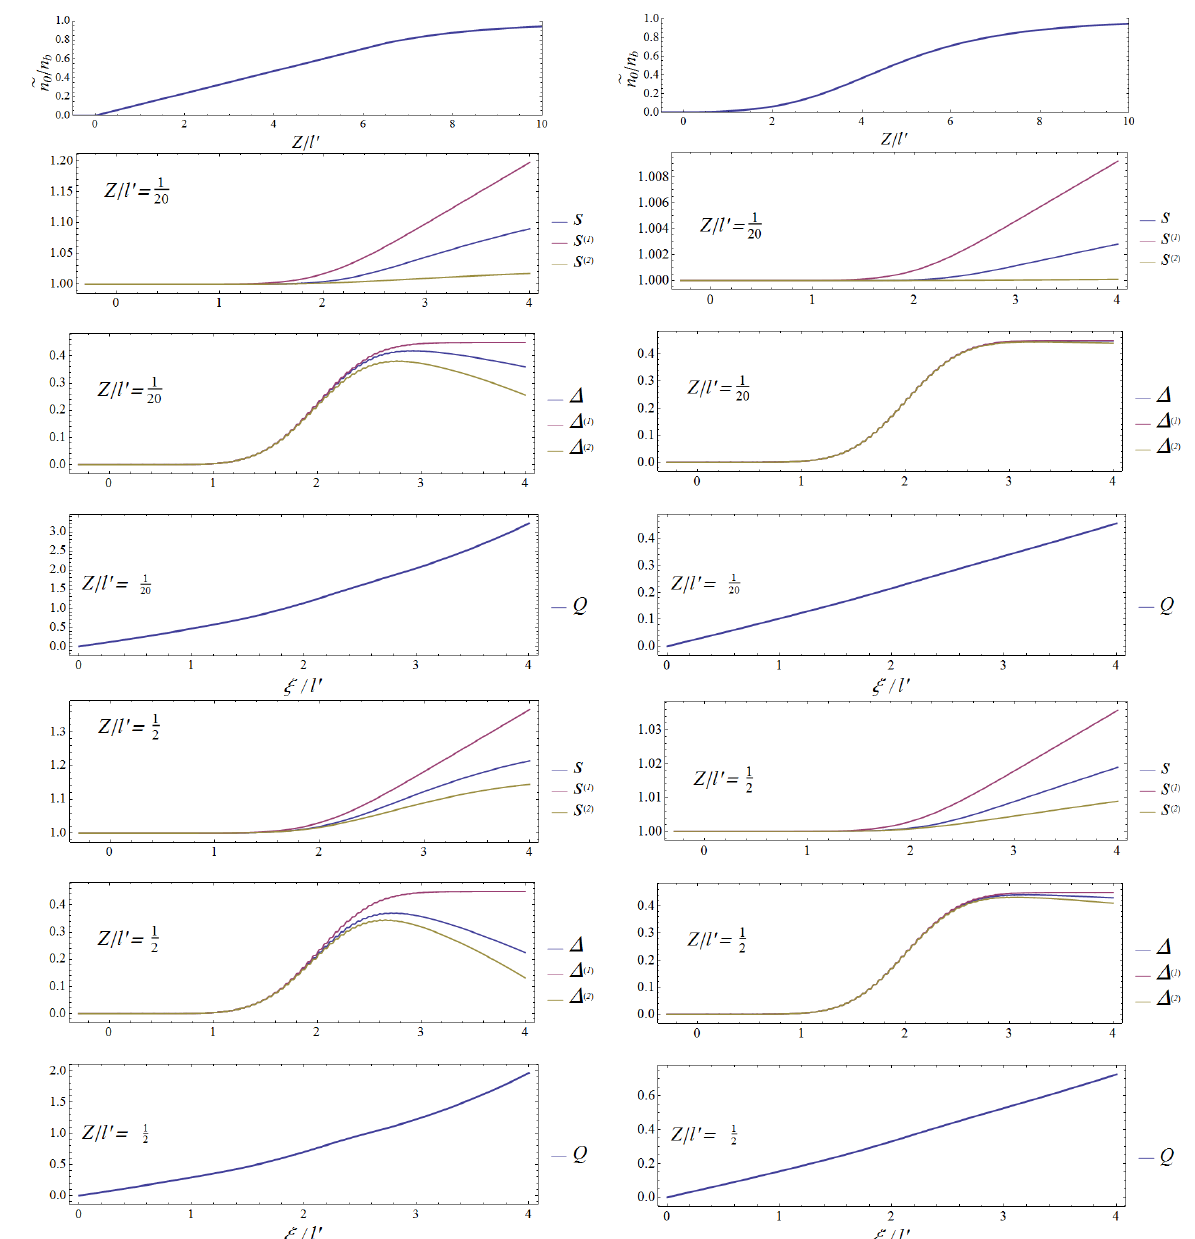
Figure 4. The initial electron densities (3), (4) of Figure 2 (left and right, respectively) with n b = 2 × 10 18 cm − 3 , corresponding plots of s , ∆ , their upper and lower bounds s ( 1 ) , s ( 2 ) , ∆ ( 1 ) , ∆ ( 2 ) , and the function Q ( ξ , Z ) , vs. ξ for the same sample values Z = l (cid:48) /20 and Z = l (cid:48) /2 of Z . The values Q 2 ( Z ) : = Q ( l , Z ) can be read off the plots. As can be seen, the bounds are much better for density (4); the values Q 2 ( Z ) ≤ 1 are consistent with all worldlines intersecting rather far from the laser- plasma interaction spacetime region. On the other hand, the large value of Q 2 ( Z ) for density (3) is an indication that worldlines intersect not far from the laser–plasma interaction spacetime region. Our computations lead to Q 0 ( l (cid:48) /20 ) = 4.62, Q 0 ( l (cid:48) /2 ) = 3.08 with density (3) and Q 0 ( l (cid:48) /20 ) = 0.49, Q 0 ( l (cid:48) /2 ) = 0.85 with density